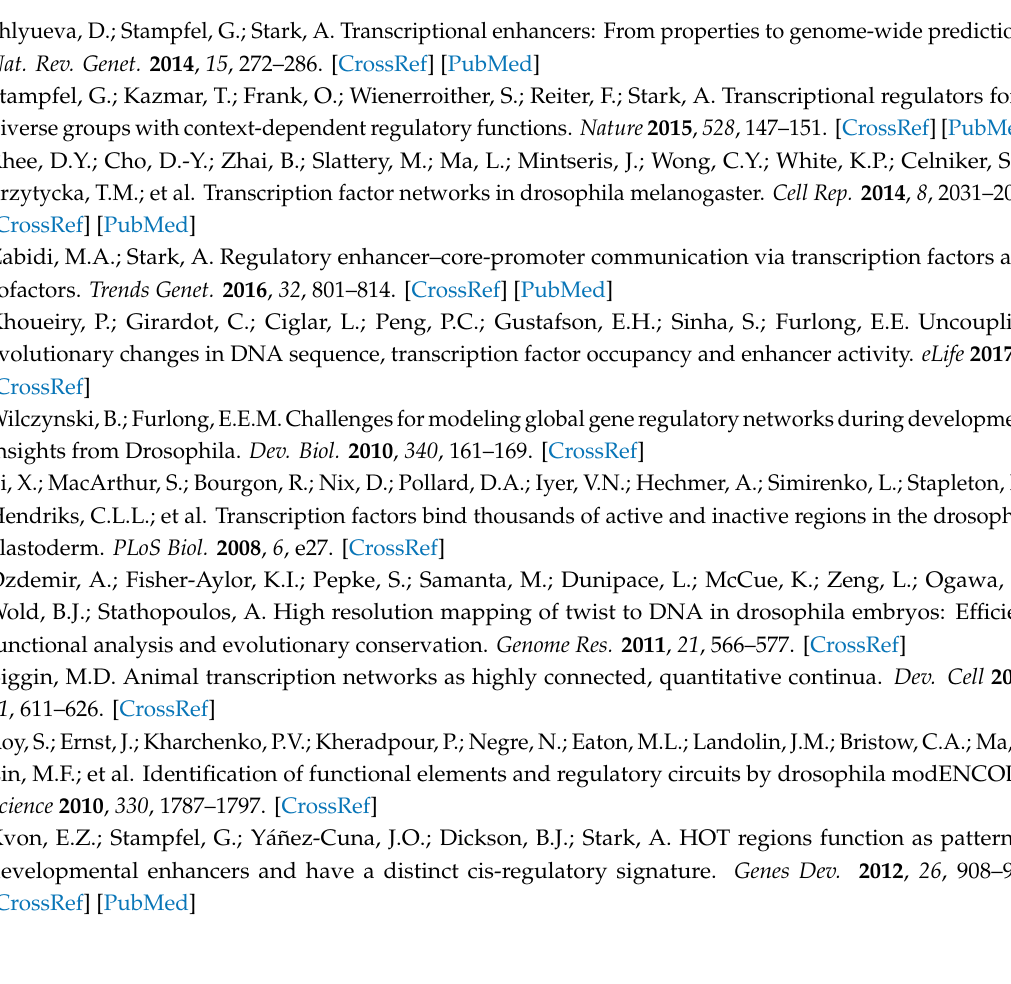
clusters identified by NetNC-FTI across the nine TF_ALL datasets, Table S6: Frequently identified genes within the Developmental Regulation Clusters, Table S7: NetNC functionally coherent TF targets found in chromatin organisation clusters across multiple datasets, Table S8: Summary of pathways selected for gold standard data TRAIN-CL and TEST-CL, Table S9: NetNC-FTI parameter values optimised for percentage Synthetic Neutral Target Genes, Table S10: NetNC-FTI parameter values optimised for percentage Synthetic Neutral Target Genes (%SNTG), Table S11: Optimisation of MCL Inflation value for the Functional Target Identification task, Data file S1: Cytoscape sessions with NetNC-FTI results for TF_ALL, Data File S2: Primers for RT-qPCR, Supplementary text: Subsampling results, related to Table